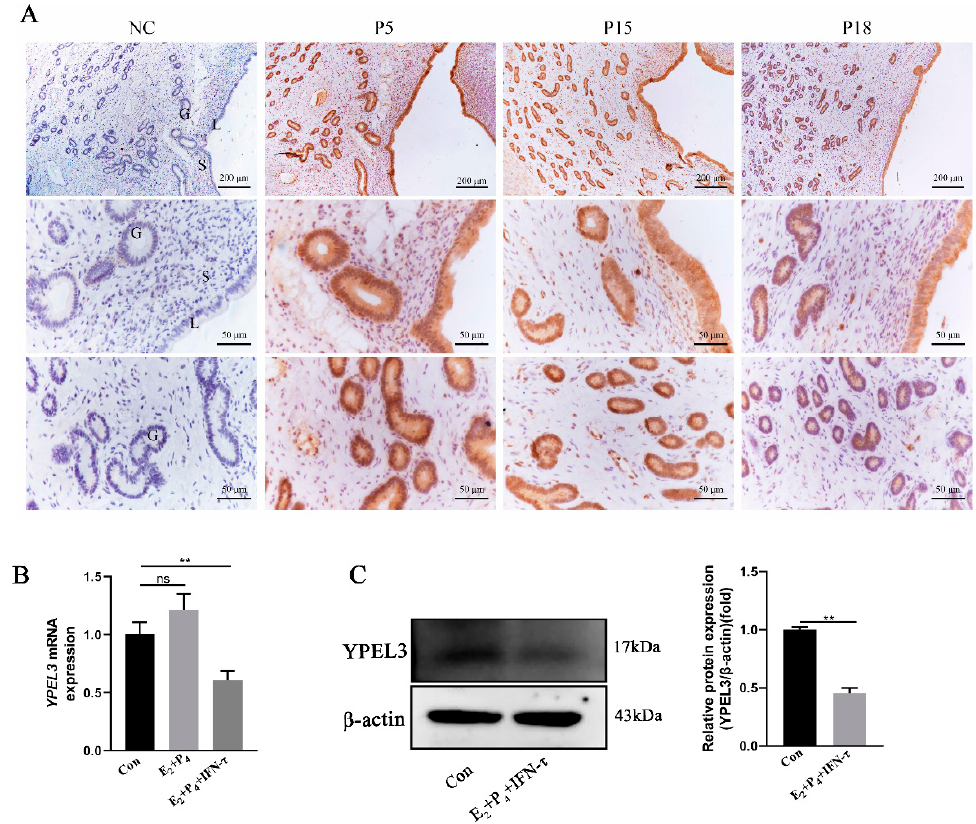
Figure 1. YPEL3 expression in the goat endometrium during early pregnancy and hormone treatment. ( A ) Immunohistochemical staining of YPEL3 protein in goat uterine tissues during early pregnancy (days 5, 15 and 18 of the pregnancy). ( B ) Real-time quantitative PCR analysis of YPEL3 mRNA levels after E 2 , P 4 and IFN- τ treatment. ( C ) Western blot analysis of YPEL3 protein expression following E 2 , P 4 and IFN- τ treatment. L, luminal epithelium; G, glandular epithelium; S, stromal cells. Scale bars = 200 µ m or scale bars = 50 µ m. ** p < 0.01, ns, not significant ( p > 0.05).